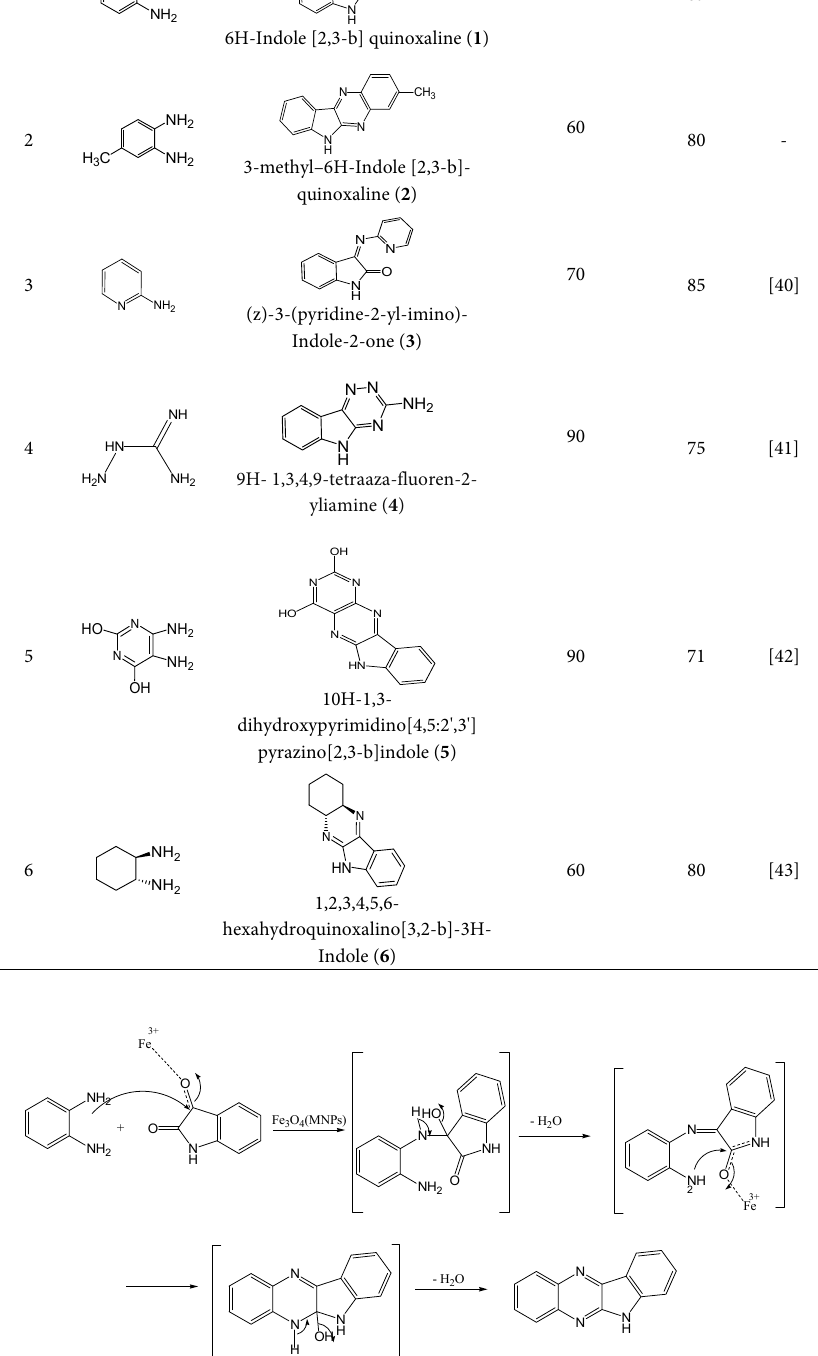
MNPs. 4 O 3 Fe tives usingSynthesis of indole deriva Table 2: O MNPs. 3 4